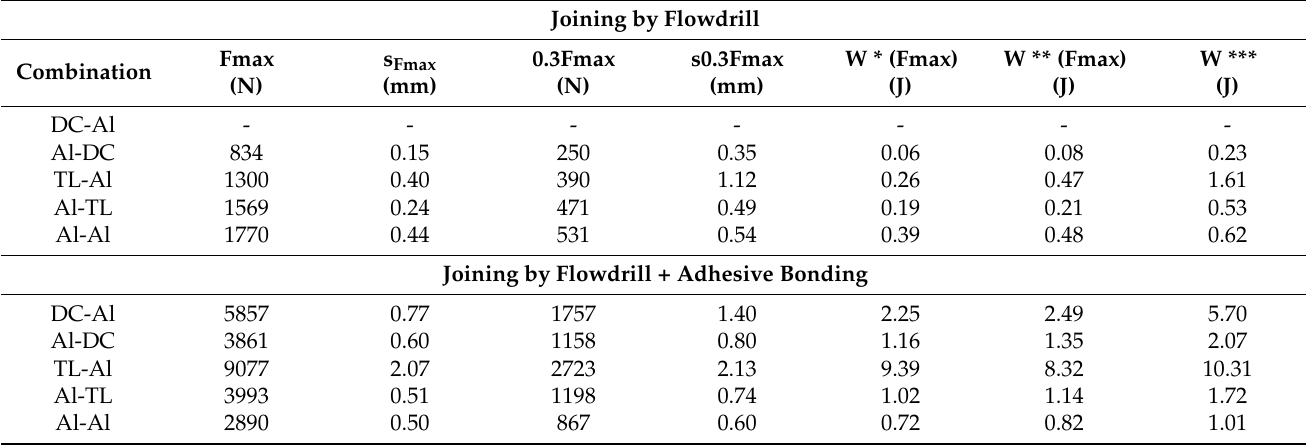
Table 10. Basic characteristics of joints and dissipated energy up to fracture. Joining by